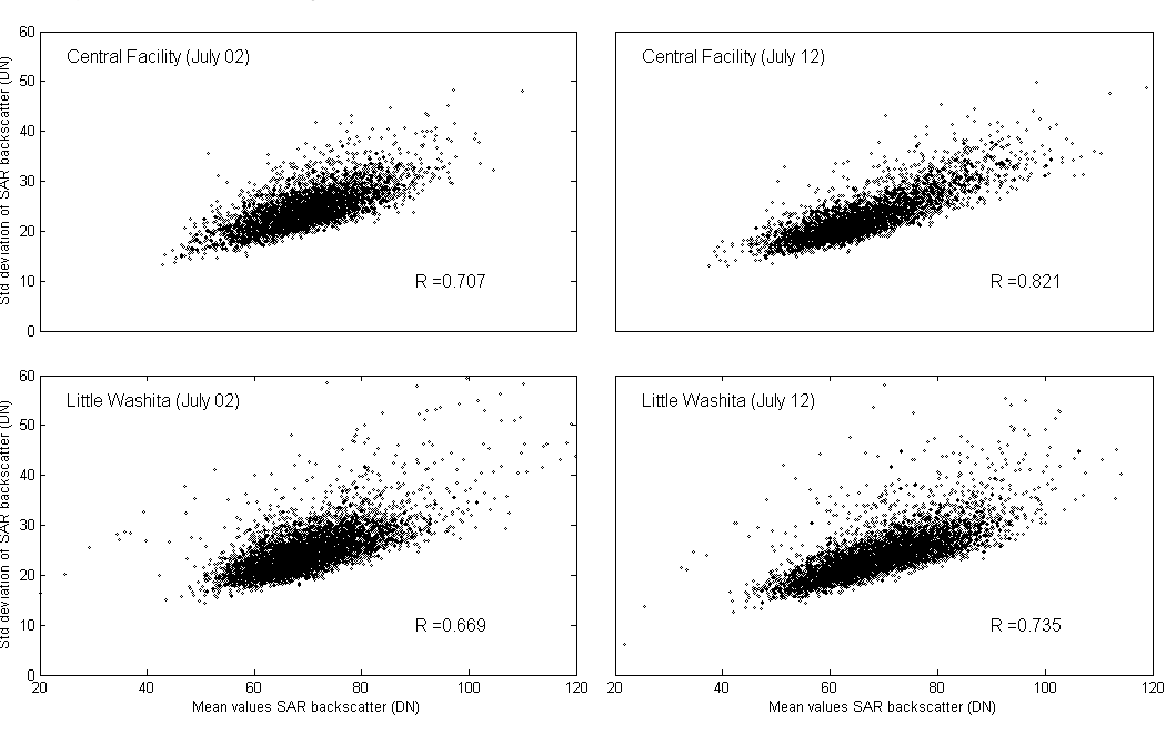
Figure 6. Sub-pixel variability of SAR backscatter to the mean values within the ESTAR footprint as measured by the standard deviation for June 2 nd and 12 th at 25 m